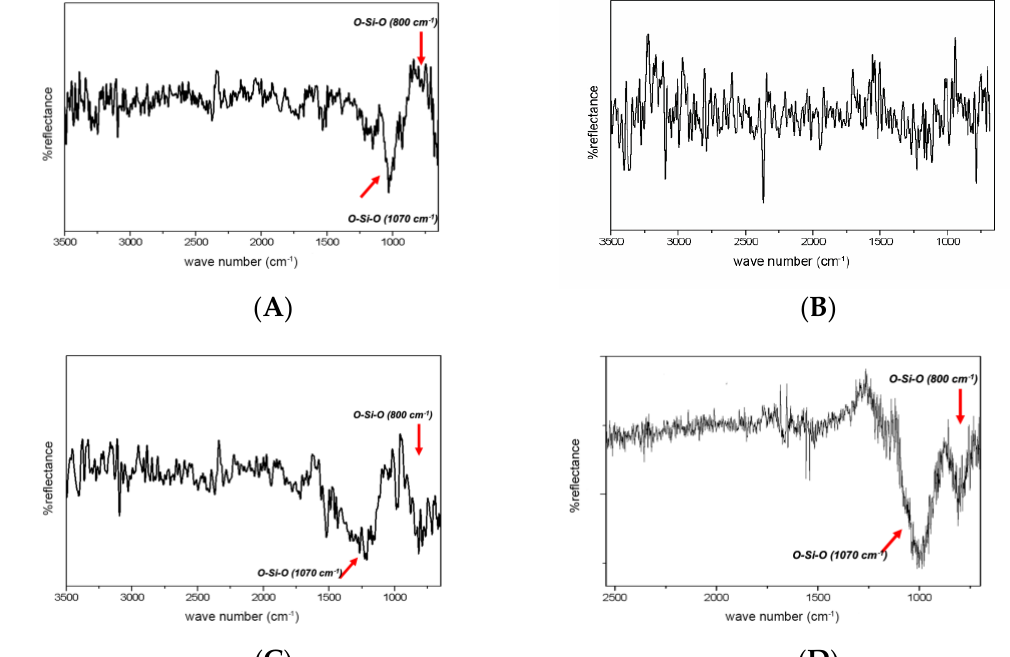
Figure 3. ATR-FTIR spectra of specimens after surface treatments: ( A ) silicatization; ( B ) HF; ( C ) HF/silicatization; ( D ) SiO 2 /Silane. Table 2. Surface roughness (Sa) of the Y-TZP discs before sintering, after sintering, and after surface treatments. Results are presented as mean (standard deviation).